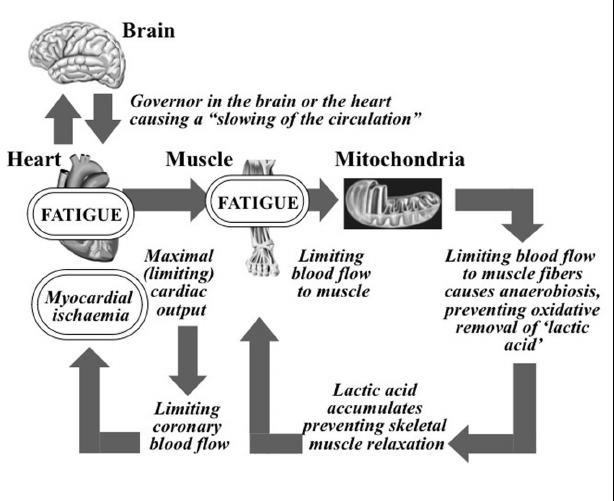
FIGURE 1 |The completeA.V. Hill Cardiovascular/Anaerobic/ Catastrophic Model of Human Exercise Performance. The governor component causing a “slowing of the circulation” was lost from the model some time after the